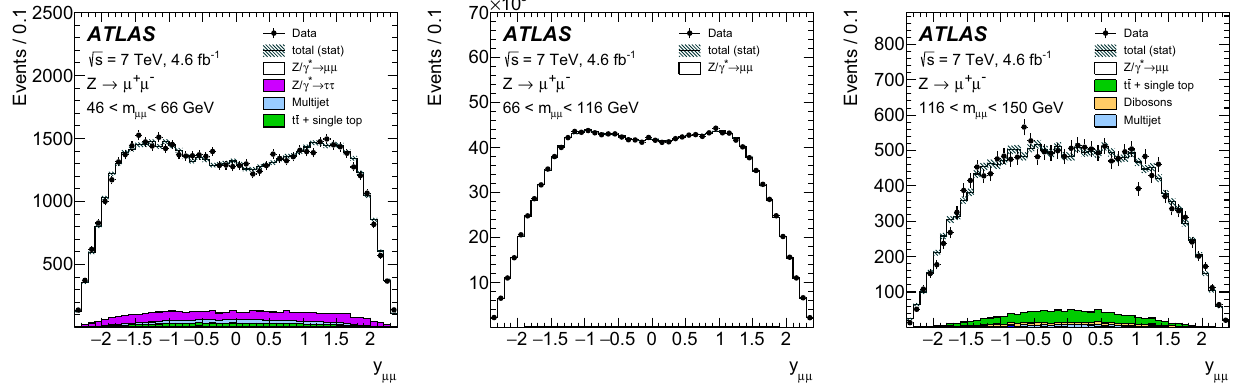
Fig. 15 The dilepton rapidity distributions for Z /γ ∗ → μ + μ − can- didates in the mass regions 46 < m μμ < 66GeV ( left ), 66 < m μμ < 116GeV ( middle ) and 116 < m μμ < 150GeV ( right ). The simulated samples are normalized to the data luminosity. The multijet background shape is taken from a data control sample and normalized to the esti-